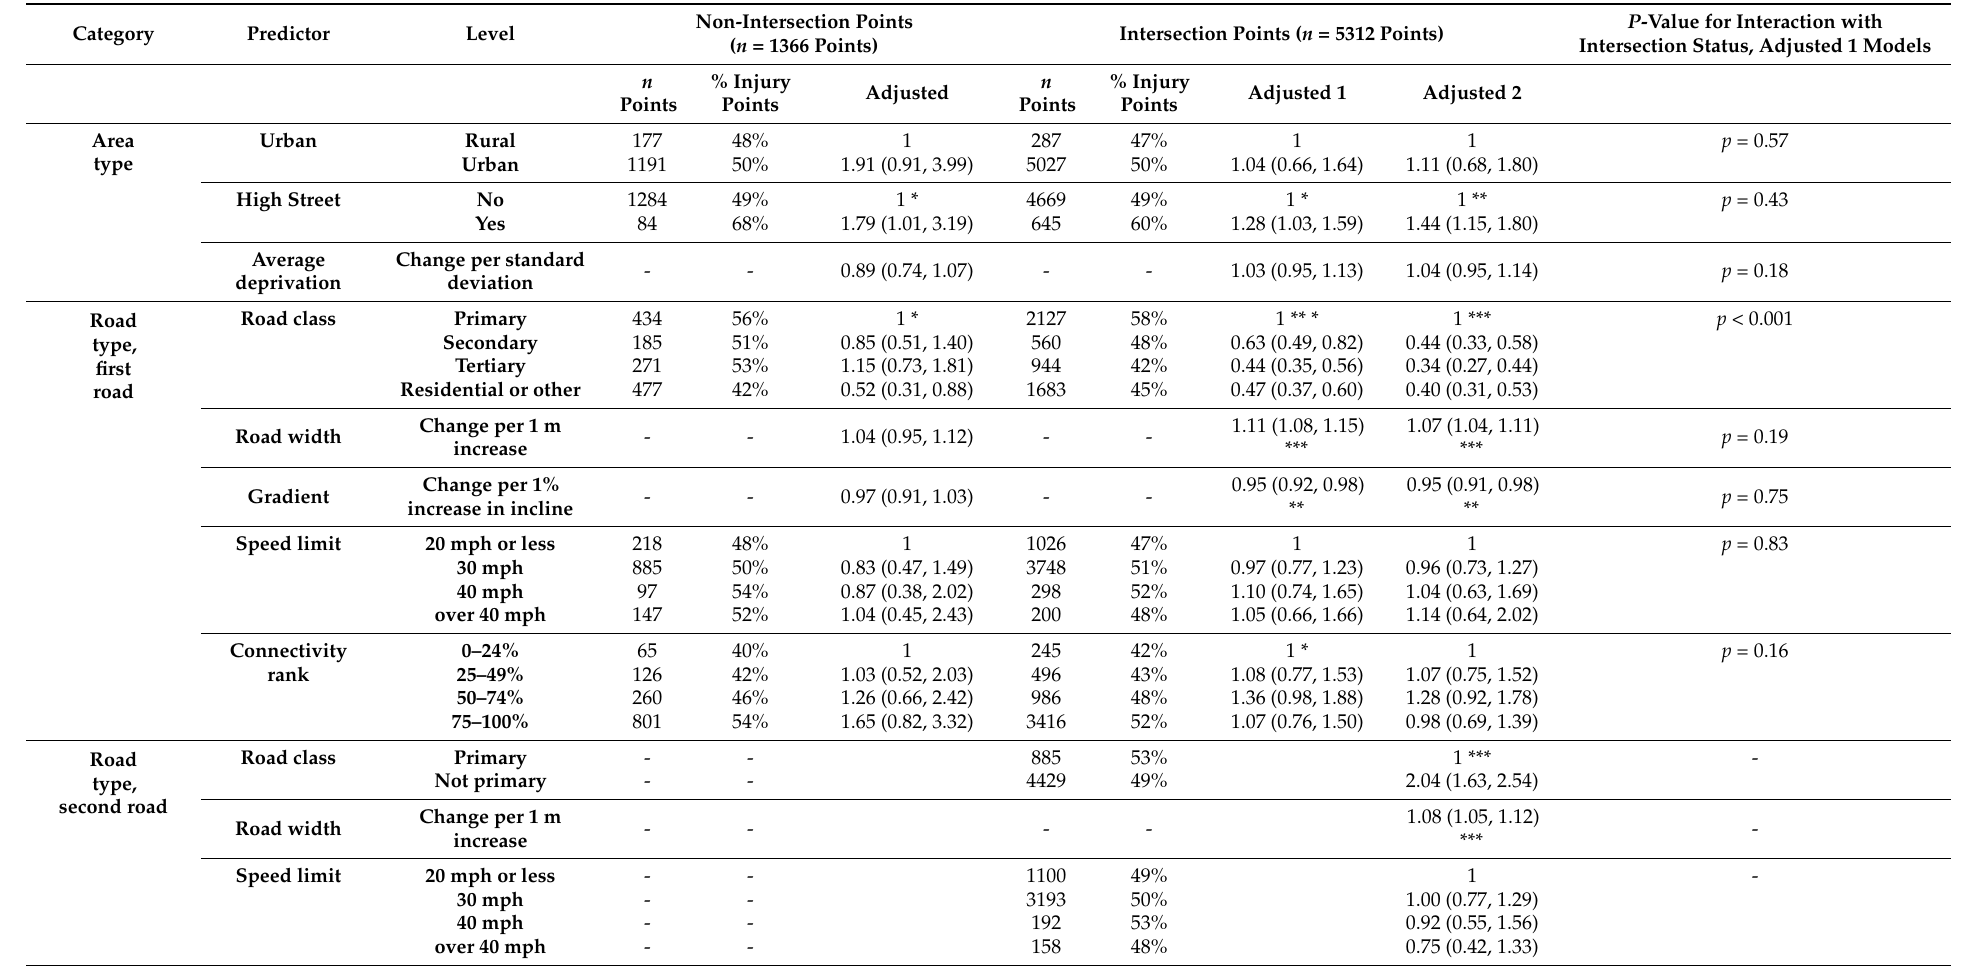
Table 3. Results separating intersection and non-intersection sites, and additional results for intersection